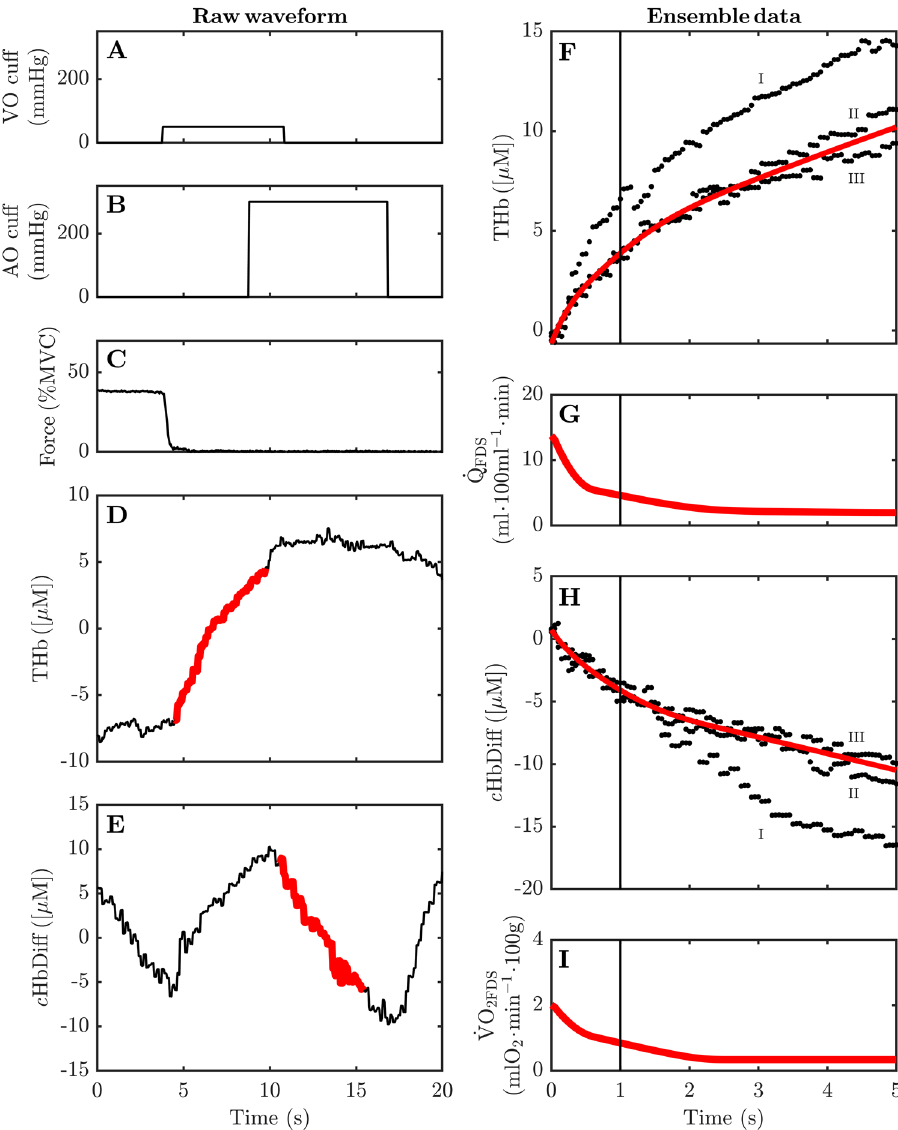
Figure 2. An example of the near-infrared waveform response to the combined venous and arterial occlusion following a 15-s isometric handgrip contraction. VO: venous occlusion; AO: arterial occlusion; MVC: maximal voluntary contraction; THb: total hemoglobin; c HbDiff: corrected hemoglobin difference; FDS: flexor digitorum ˙ Q ˙ VO superficialis; : muscle blood flow; 2 : muscle O 2 uptake. The solid lines in ( A ) and ( B ) denote the relative timing of venous and arterial occlusions during the combined protocol (COMBO). The solid lines in ( C – E ) represent the continuous waveform response to the COMBO occlusion protocol immediately following an isometric handgrip contraction at 40%MVC. The thickened red lines in ( D ) and ( E ) denote the periods of ˙ Q ˙ VO data used to compute and 2 , respectively, of the FDS muscle. The solid dots in ( F ) and ( H ) represent the ensemble of [THb] and [ c HbDiff] waveforms obtained during COMBO occlusions following 40%MVC handgrip exercise in this particular individual. The numerals I, II and III in ( F ) and ( H ) illustrate from which of the 3 repeated trials waveform data were obtained. The solid red lines in ( F ) and ( H ) depict the best-fit nonlinear spline after the processes of iterative reweighting was complete. Note that the iterative reweighting approach has deemphasized the observations belonging to the aberrant waveform in each dataset. The solid red lines in ( G ) and ( I ) are the first-order derivatives obtained from the best-fit splines in ( F ) and ( H ). The vertical solid lines in ˙ Q ˙ VO ( F – I ) indicate the first 1-s of the COMBO occlusion over which the and 2 waveforms were